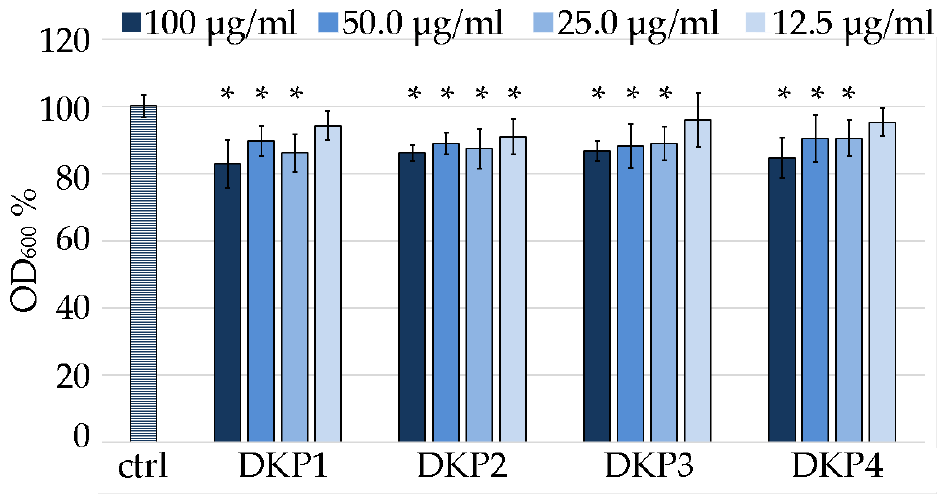
Figure 8. Minimum inhibitory concentration assay on S. aureus for DKPs 1–4 measured as OD 600 normalized to the untreated S. aureus (100% control, ctrl). * denotes p < 0.01.